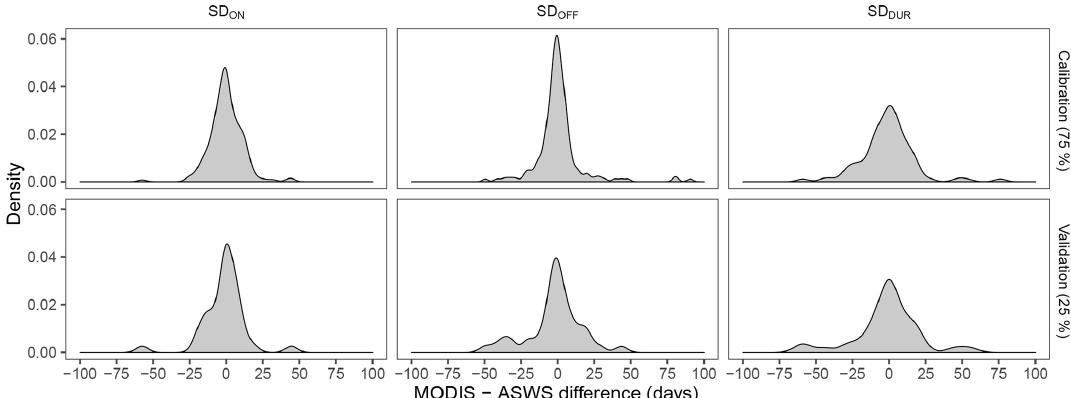
Figure 5. Distribution of errors calculated from the difference between MODIS and ASWS values for each snow measurement. Using the calibration dataset (75% of the ASWS data) for SD ON , SD OFF , and SD DUR , respectively, the mean error is 0.82, 0.62, and − 1 . 64d; the mean absolute error (MAE) is 8.7, 8.9, and 13.1d. Using the validation dataset (25% of the ASWS data) for SD ON , SD OFF , and SD DUR , respectively, the mean error is 2.5, − 2 . 1, and − 4 . 0d; the MAE is 12.7, 12.6, and